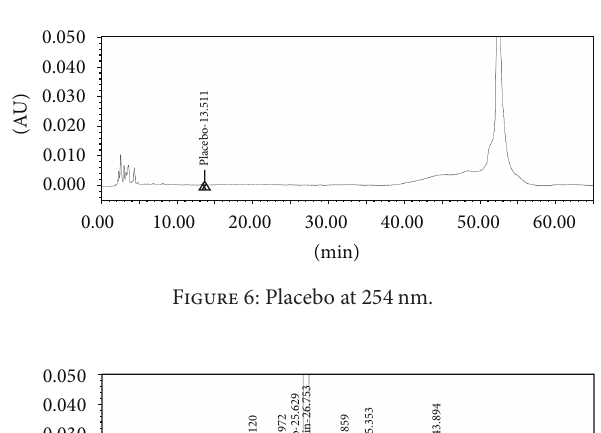
Figure 5: Placebo at 278 nm.